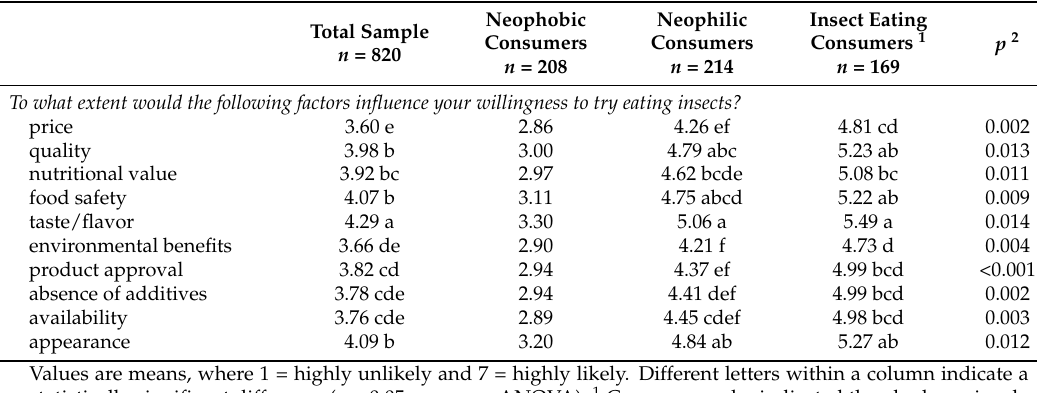
Table 4. Factors influencing consumer willingness to try eating